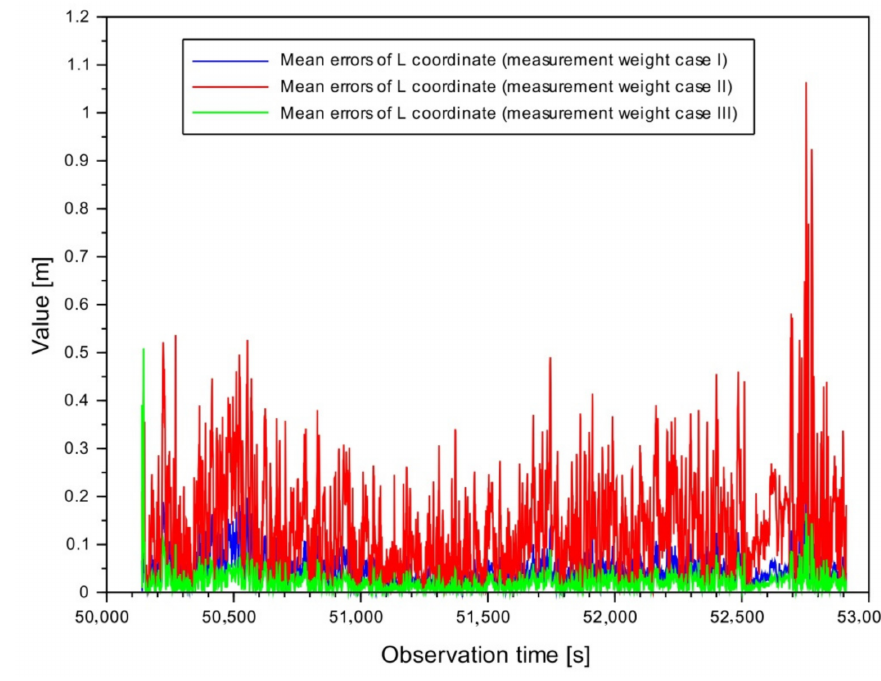
Figure 8. Mean errors of L resultant coordinate.